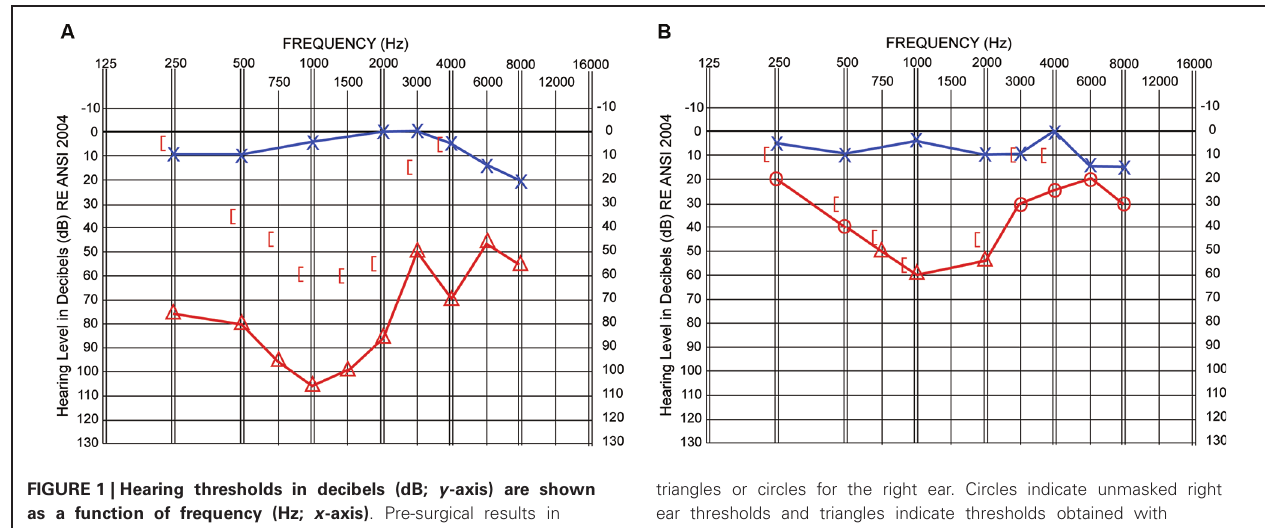
triangles or circles for the right ear. Circles indicate unmasked right ear thresholds and triangles indicate thresholds obtained with masking noise presented to the better hearing left ear. Masked bone-conduction thresholds for the right ear are indicated with red left-facing